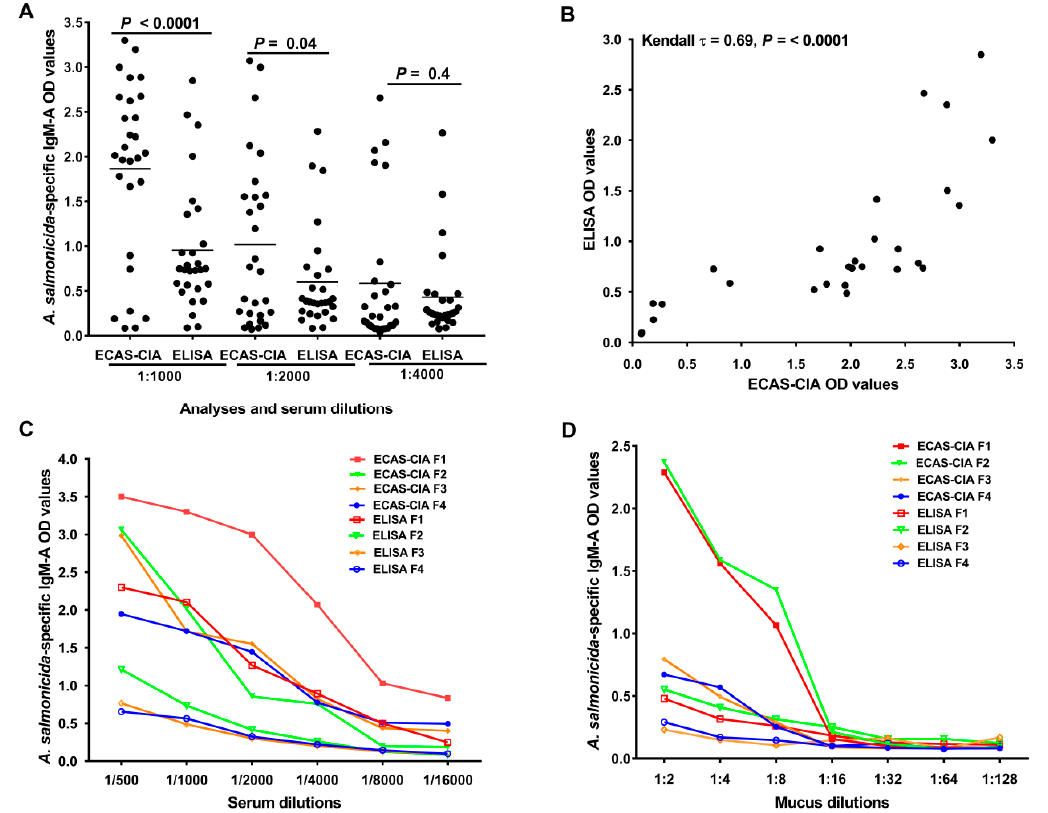
Figure 2. Establishment of the ECAS-CIA method using serum and mucus samples from Atlantic salmon. ( A ) Scatter dot plot comparing signal intensities of ECAS-CIA and ELISA after screening serum samples (D2; n = 28) at different dilutions for specific IgM-A response against A. salmonicida antigens found in the ALPHA JECT vaccine. Horizontal lines represent the median OD values in different groups. p -values were calculated using a Wilcoxon signed-rank test. ( B ) Kendall’s rank correlation test for association between ECAS-CIA and ELISA OD values (450 nm) of A. salmonicida -specific IgM-A in serum samples (at a 1:1000 dilution) from vaccinated salmon (D2; n = 28). Titration curves comparing the sensitivity of ECAS-CIA and ELISA methods using ( C ) serum and ( D ) mucus samples collected from four fish (F1 – F4) with different ELISA OD values. In these titration curves A. salmonicida -specific IgM-A OD values (450 nm) were measured in samples with different dilutions.